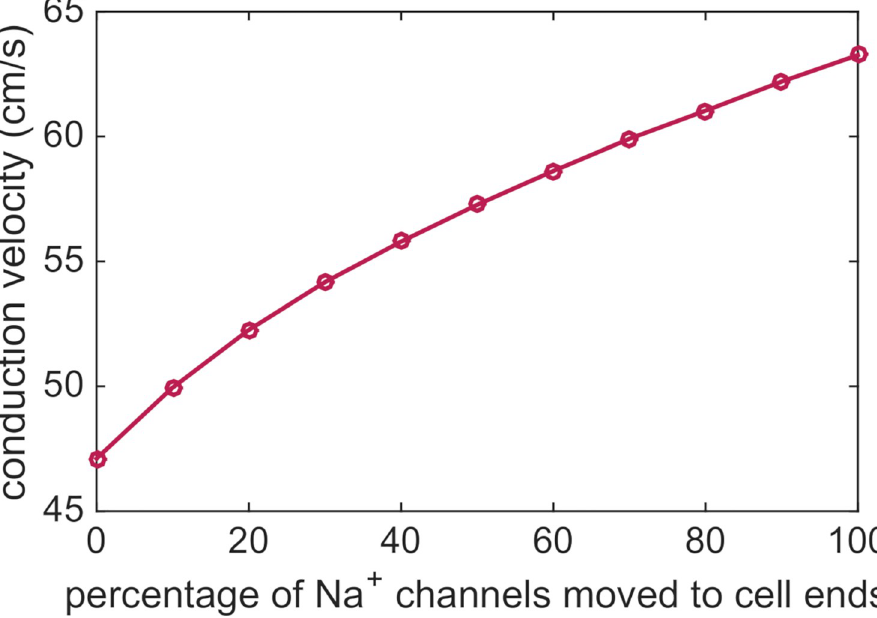
Fig 4. The conduction velocity increases as a larger percentage of the sodium channels is moved to the cell ends. The parameters used in the simulations are given in Table 1, and the simulation includes 15 cells. The conduction velocity is computed as the distance between the cell centers of the fifth and tenth cells divided by the time between the two cell centers first reach a membrane potential of v = 0